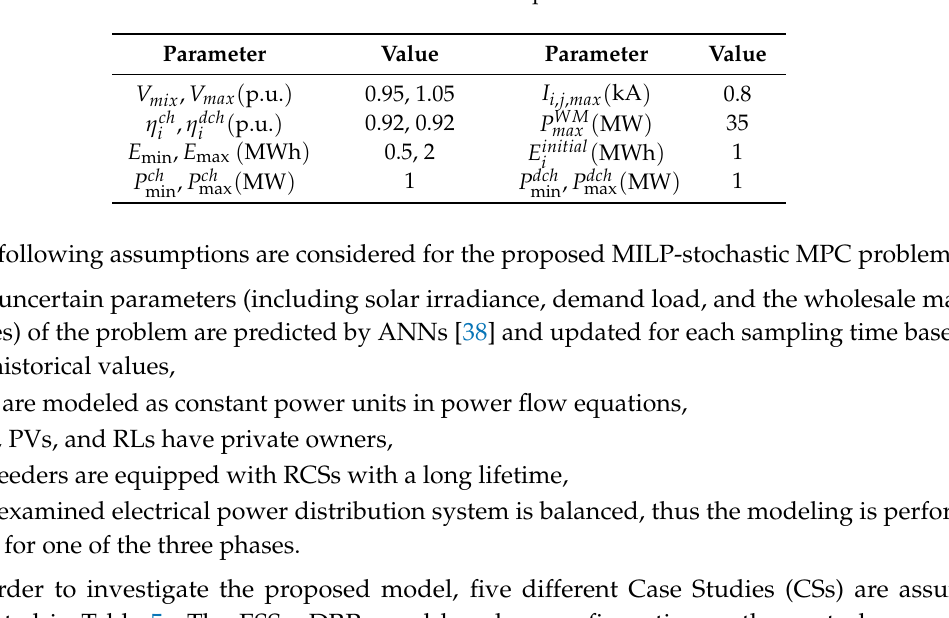
Table 4. Values for technical parameters.